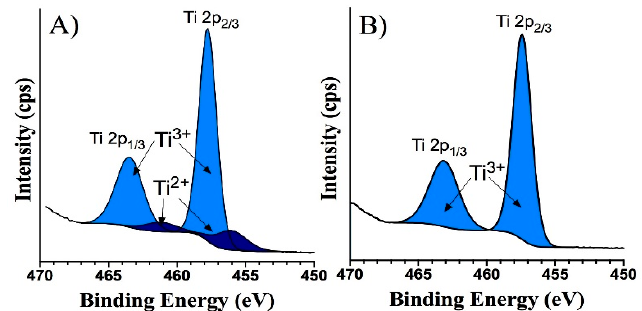
Figure 4. Narrow scan XPS spectra of Ti2p region in ( A ) undoped and ( B ) Eu-doped TiOx thin films.